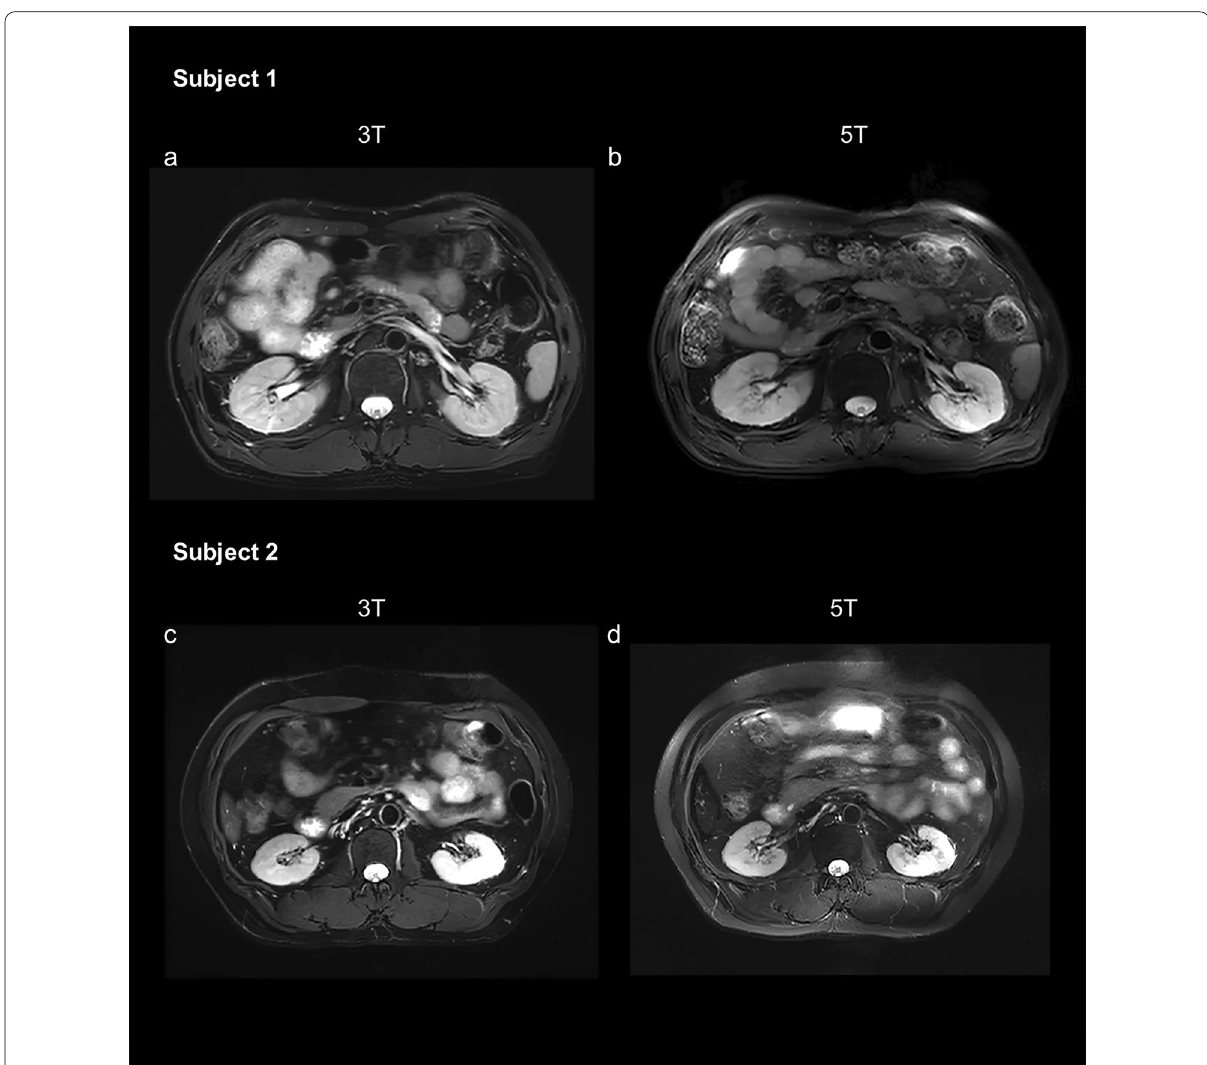
Fig. 2 Axial, T2-weighted fast spin echo (FSE) sequence at 3 T ( a and c ) and 5 T ( b and d ) from subject 1 (49-year-old male) and subject 2 (40-year-old male). For subject 2, T2-weighted FSE at 5 T exhibited a higher level of artifacts compared to the 3 T